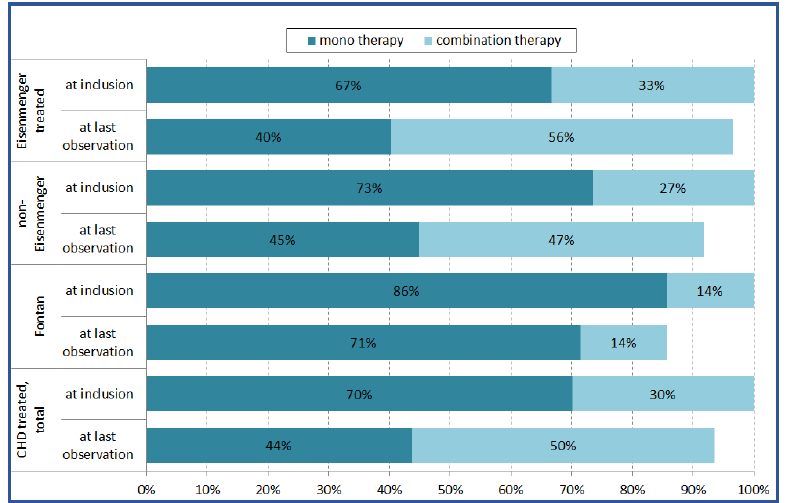
Figure 3. Targeted mono- or combination therapy in 512 CHD patients with PAH, with at least